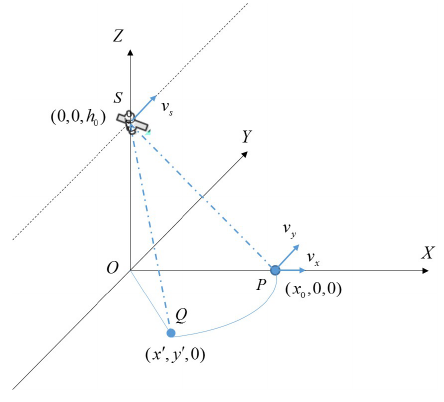
Figure 2. Acquisition geometry. Table 2. Target/SAR motion